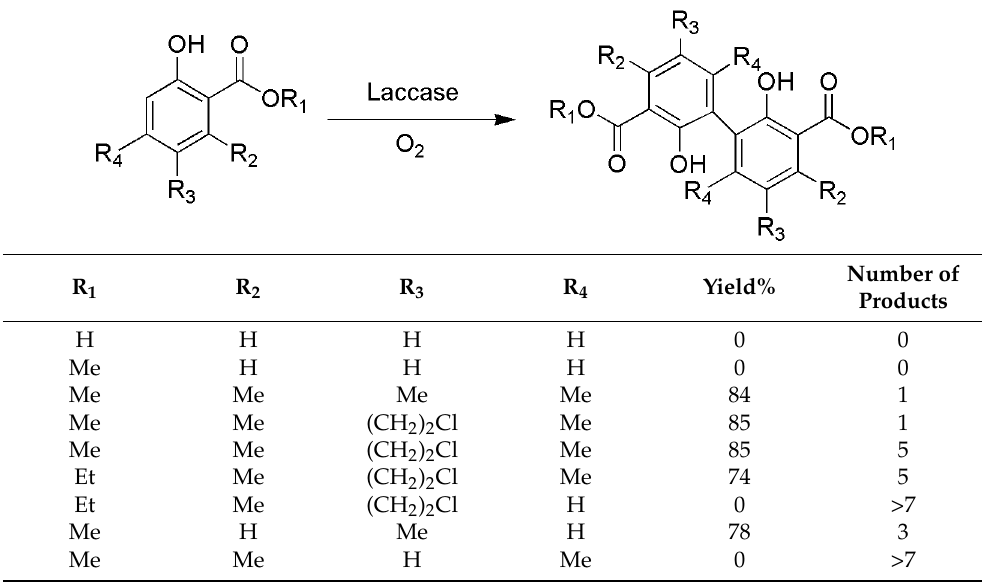
Table 5. Overview of the oxidative homocoupling of salicylic esters conducted by Ciecholewski.